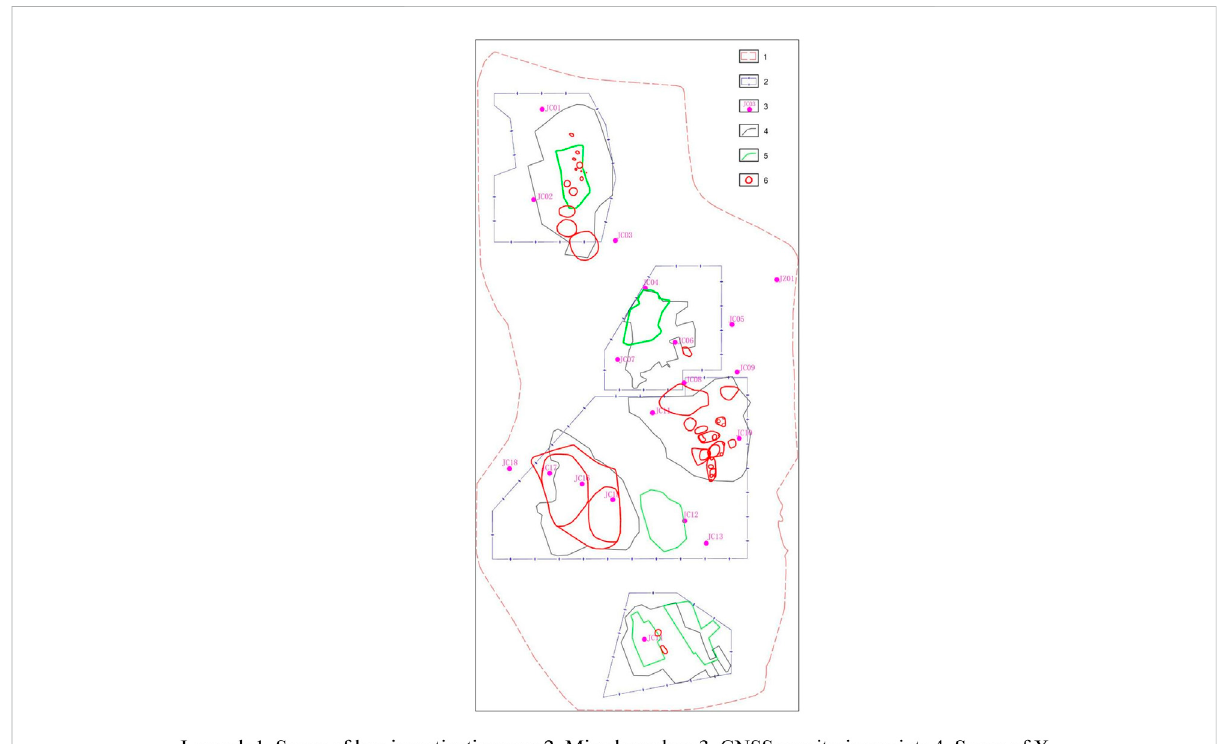
FIGURE 6 GNSS plan layout. 1. Scope of key investigation area 2. Mine boundary 3. GNSS monitoring points 4. Scope of X gypsum goaf 5. Scope of VI gypsum goaf 6. Collapse